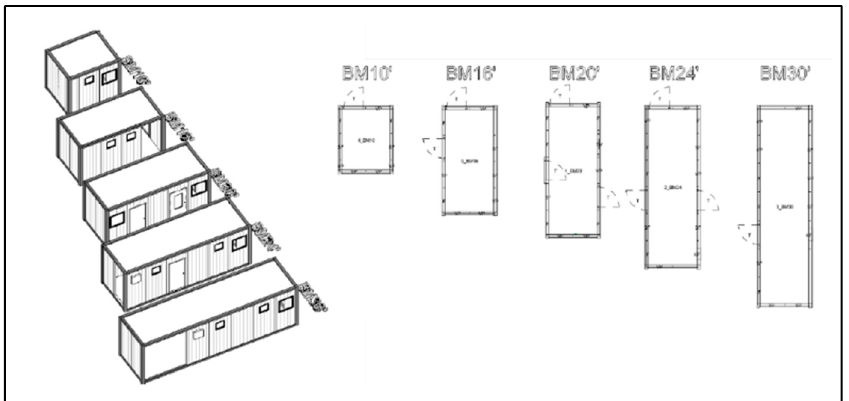
Figure 7. Building Information Modeling (BIM) object library in basic configuration.